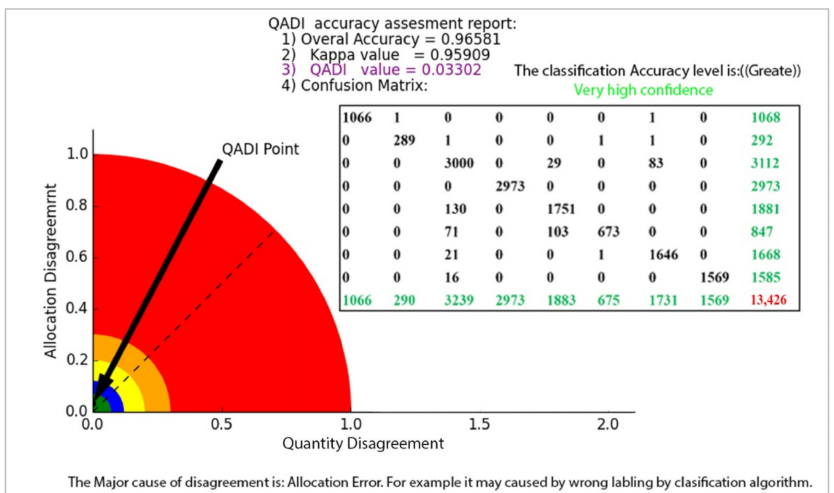
Figure 10. The QADI graph for the error matrix of LULC classification based on SVM (Table 9) developed by Leeuwen et al.